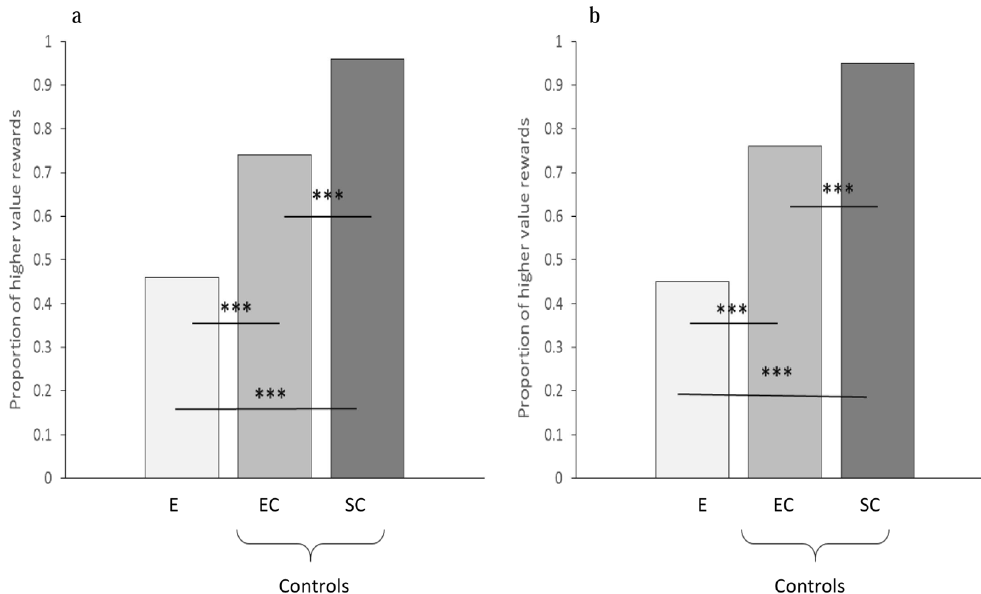
Figure 4. The proportion of higher value rewards selected by child B in the empty control, self-centered control, and experimental trials of the test (panel a) and retest (panel b) phases of the non-agent condition. Note. E = experimental trials, EC = empty control trials, SC = Self-centered control trials. *** p <